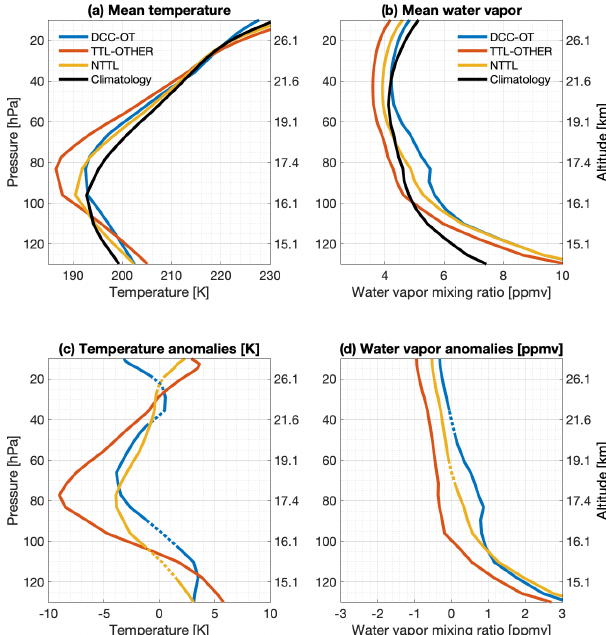
Figure 9. The mean (a) temperature (K) and (b) water vapor (ppmv) profiles above cyclones, for overshooting TTL clouds (DCC-OT, blue), non-overshooting TTL clouds (TTL-OTHER, or- ange), and non-TTL clouds (NTTL, yellow), along with the clima- tology (black). (c, d) The same as (a, b) but for anomalies with respect to the climatology.